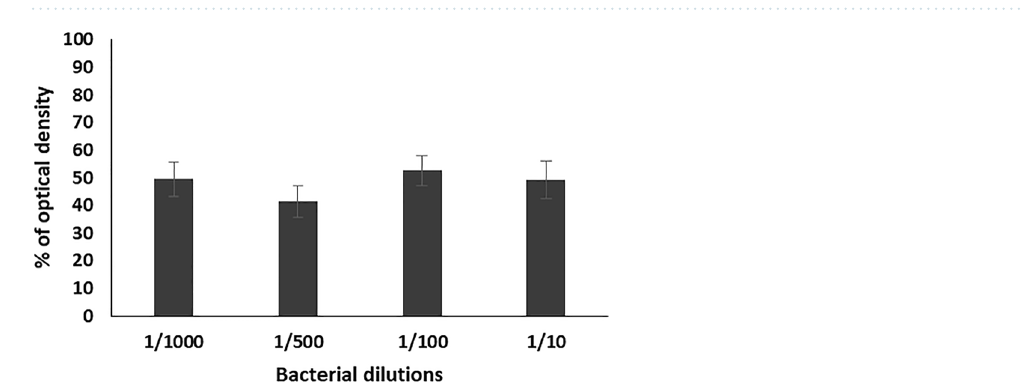
Figure 3. Percentage of optical density of the formed biofilms of 17 enterococcal isolates, prepared in different dilutions (1/10, 1/100, 1/500, and 1/1000) from bacterial suspension adjusted to 0.5 MacFarland, in the presence of the six bacteriophages (EPA, EPB, EPC, EPD, EPE, EPF) as compared to the control. Each bar represents the mean of three independent